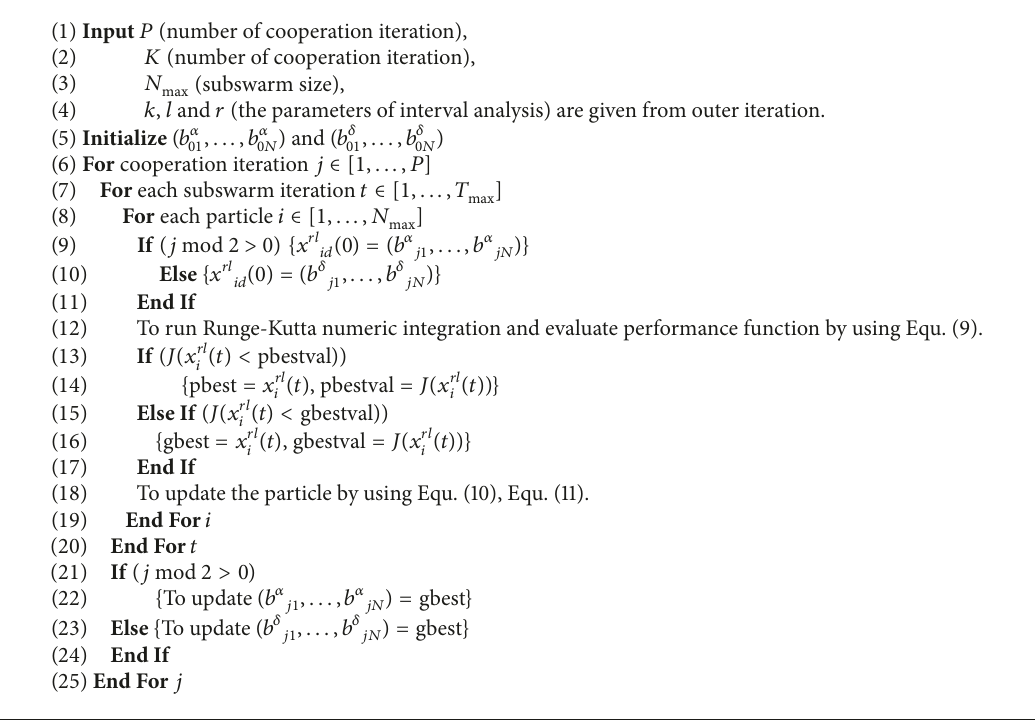
Pseudocode 1: Pseudocode of